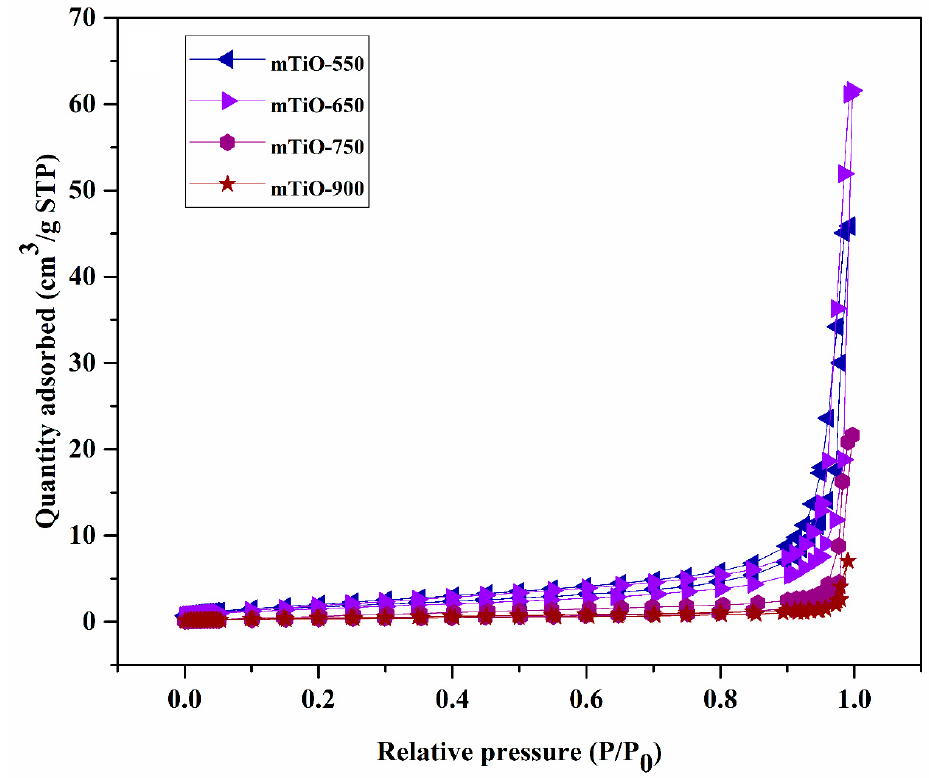
Figure 7. N 2 adsorption/desorption of treated mTiO catalysts.